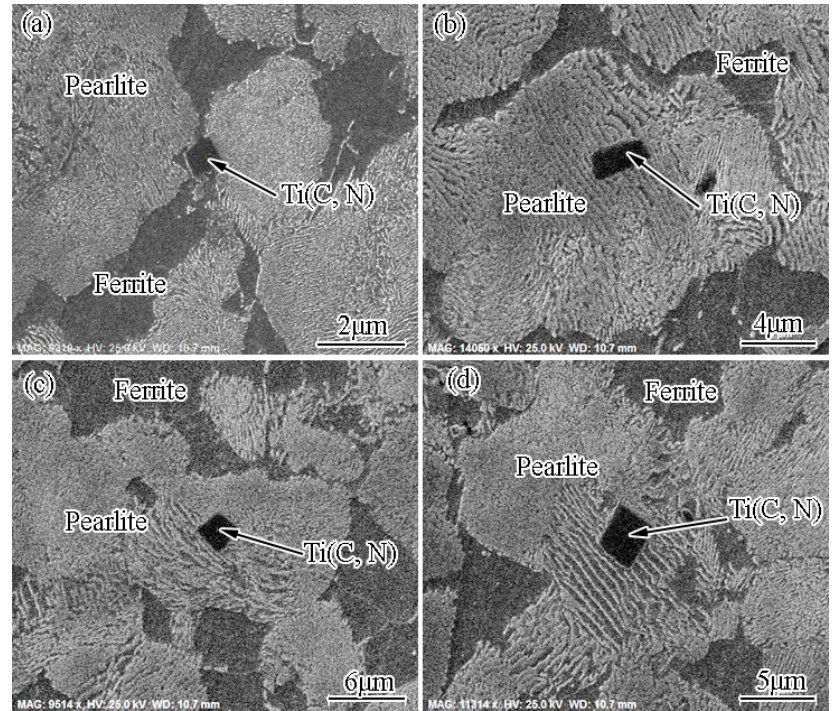
Figure 9. Coarse Ti(C, N) particles located in ferrite ( a ) and pearlite ( b – d ) in steel 2.